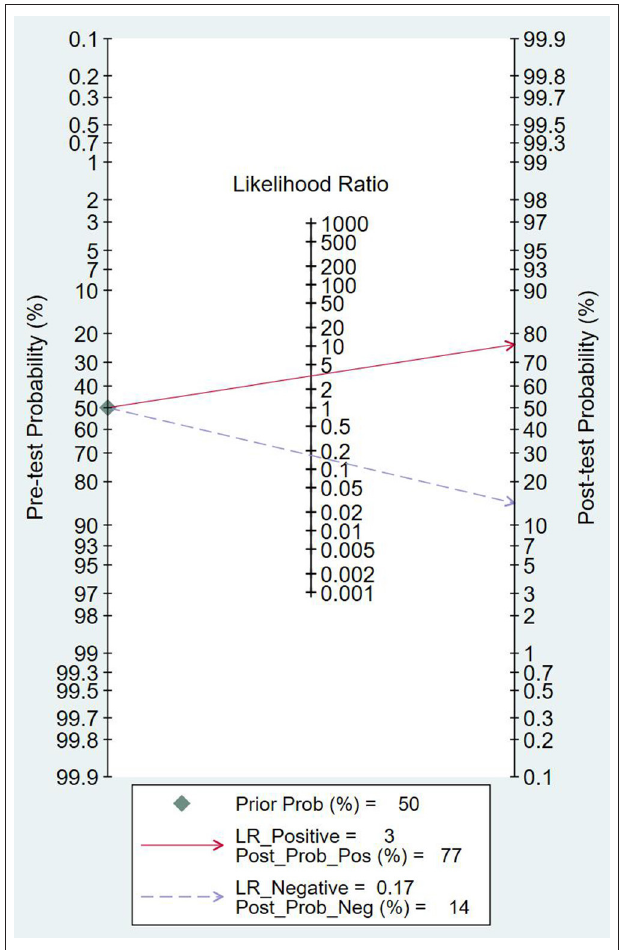
FIGURE 8 | The Fagan map.